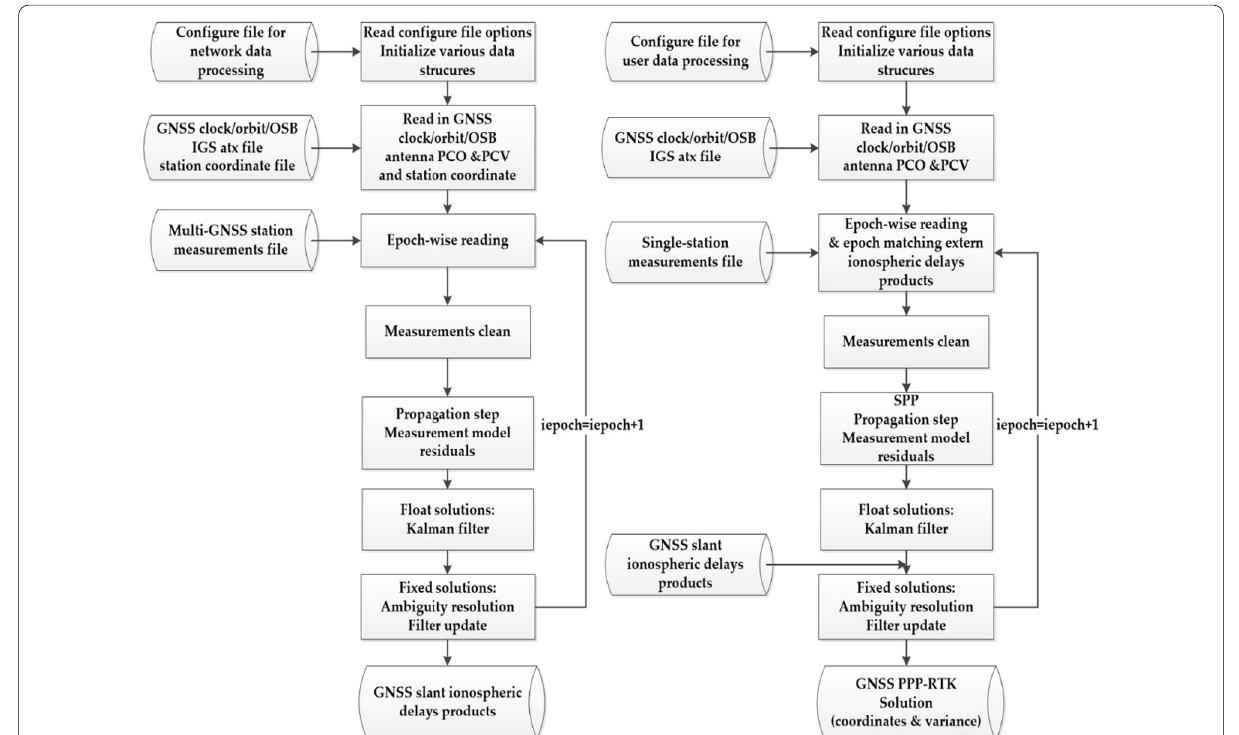
Fig. 3 Flowchart of the PPP-RTK platform of the network components (left) and the PPP-RTK platform of the user components